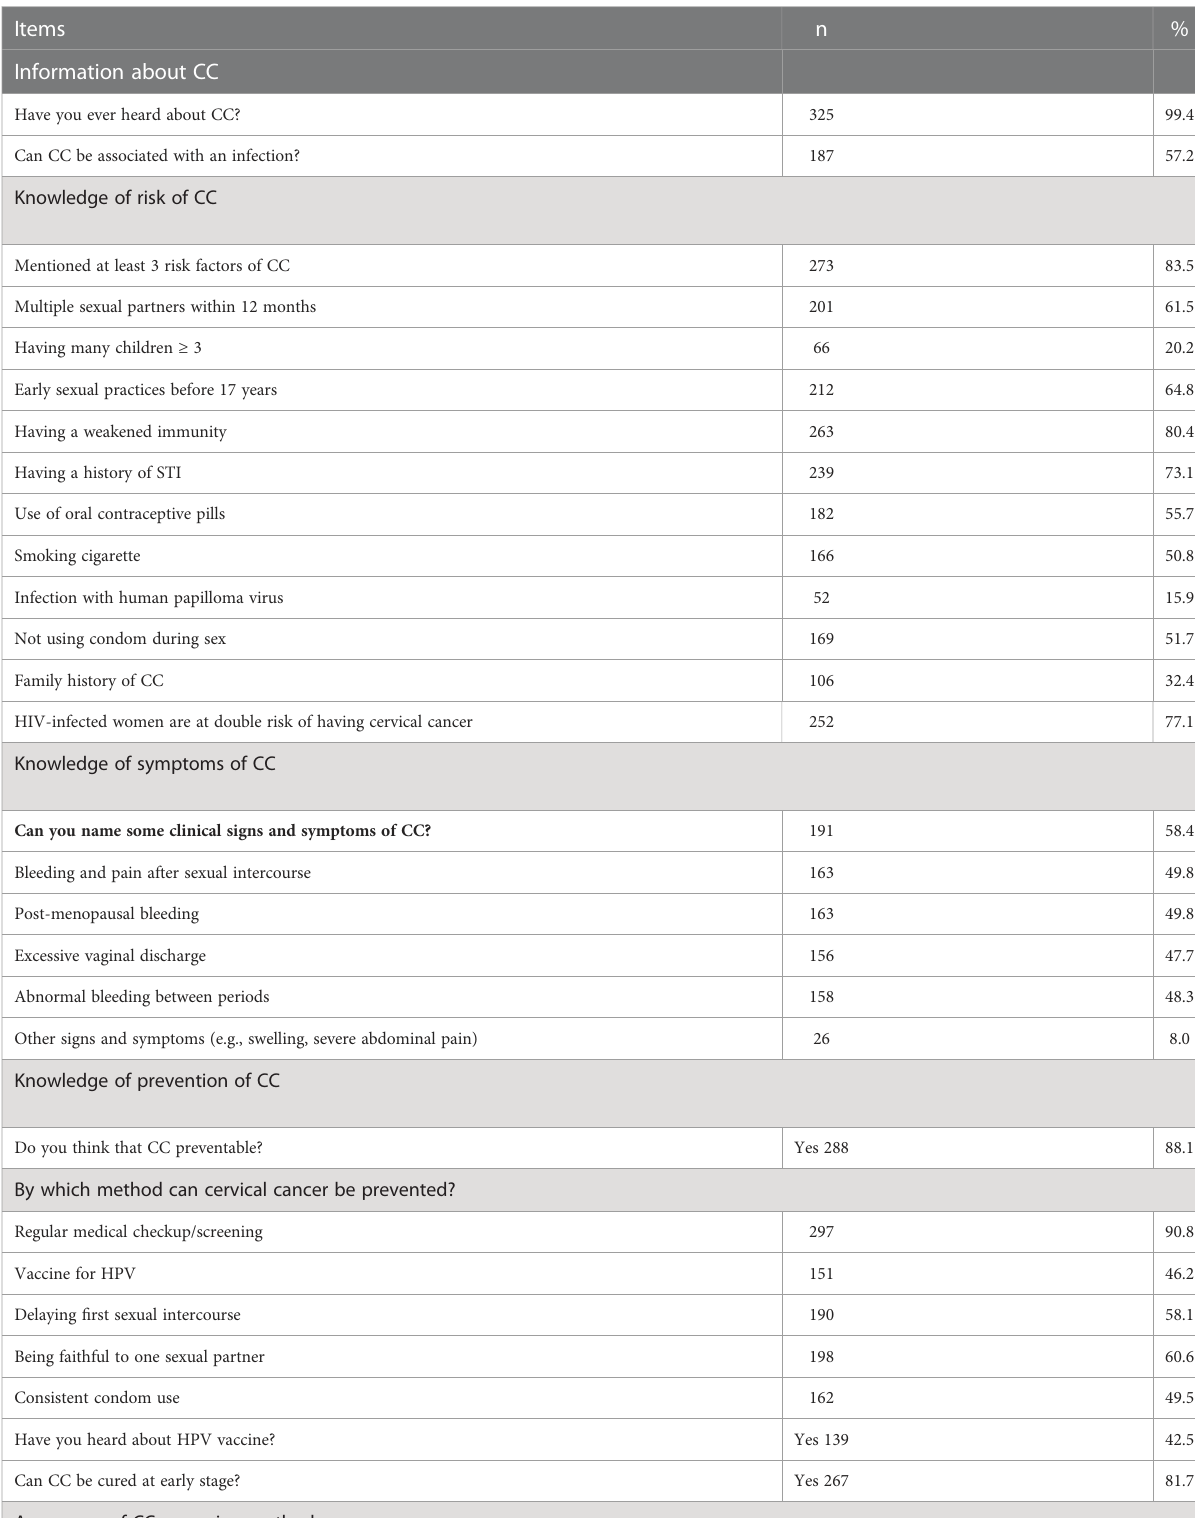
TABLE 2 Knowledge and awareness of CC among